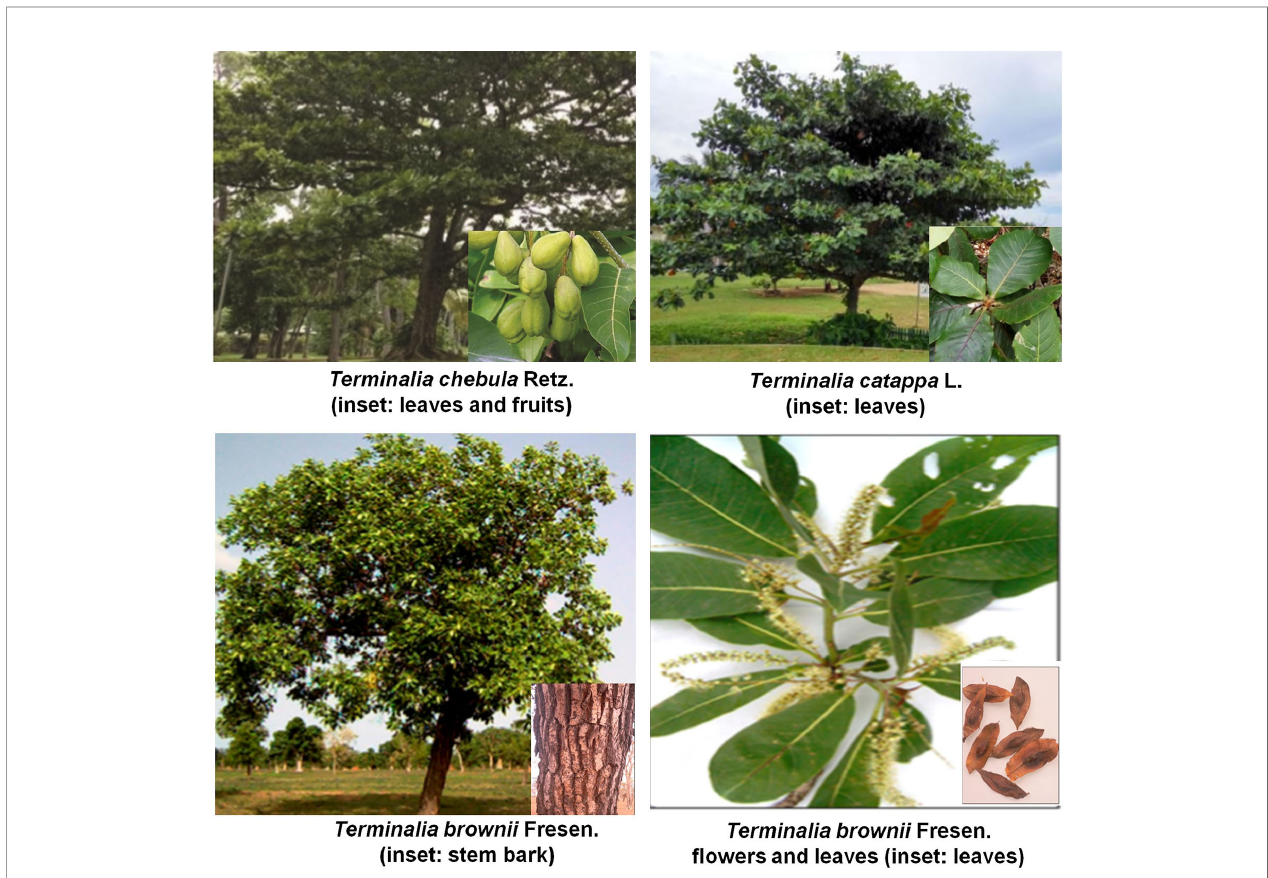
FIGURE 1 | Some of the common Terminalia sp. Reproduced under the Creative Commons Attribution License (Afshari et al., 2016; Marjenah and Putri, 2017; Salih et al.,